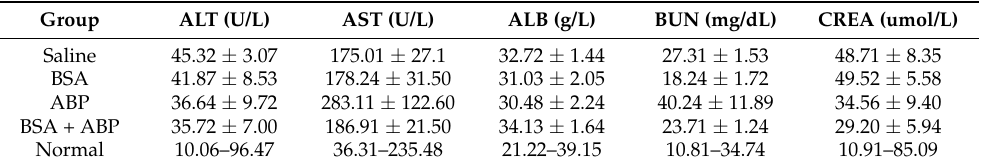
Figure 5. Evaluation of the safety of BSA saturation dose in antitumor efficacy. Histological assess- ment of the heart, liver, lung, spleen, and kidney. Table 1. Detection results of liver and kidney indexes in serum ( n = 3).